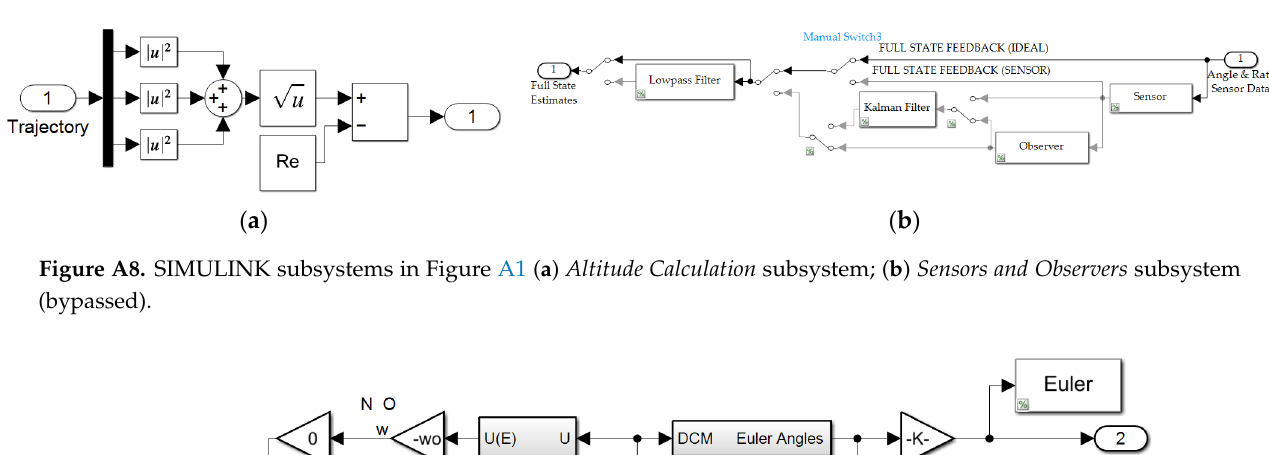
Figure A7. SIMULINK subsystems in Figure A1 ( a ) Applied Tether Force subsystem; ( b ) Magnitude subsystem.